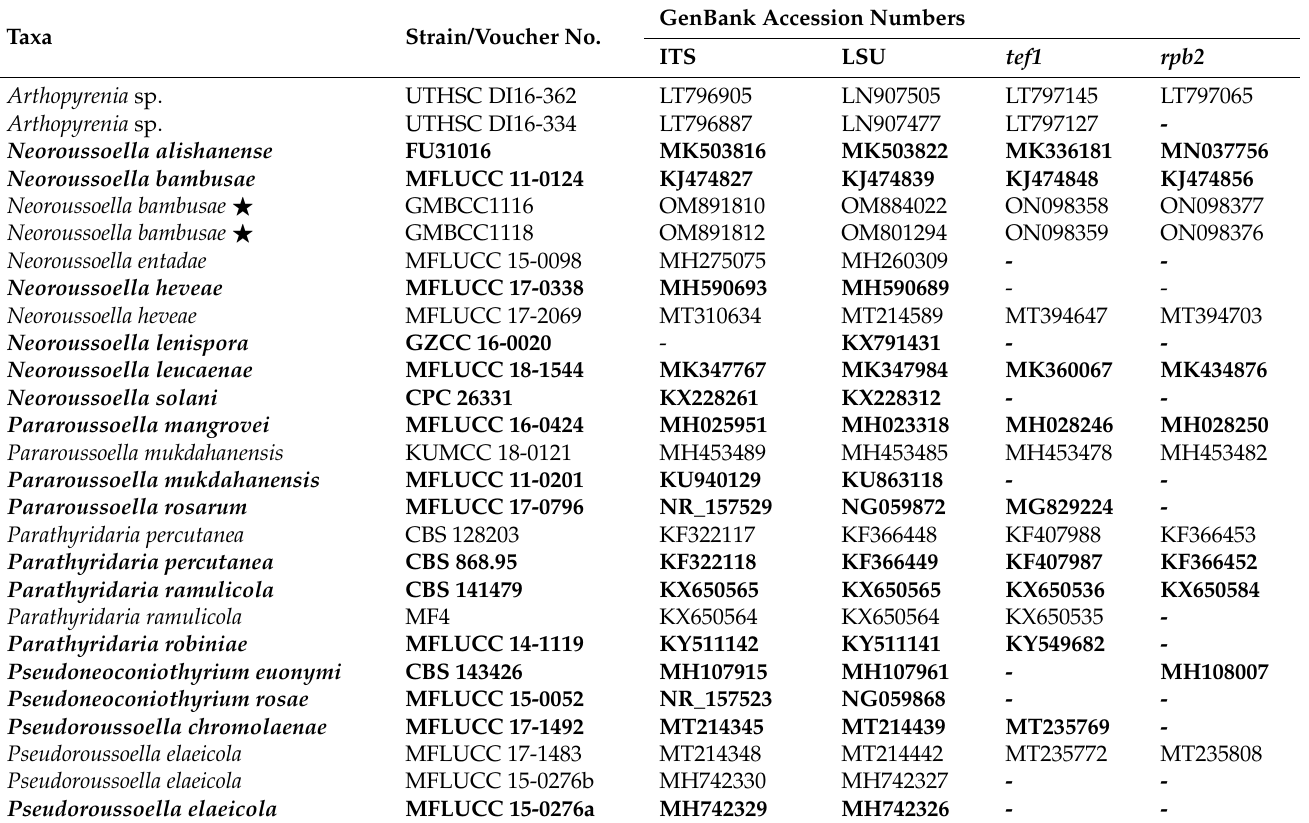
Table 3. Isolates or specimens used in this study and their GenBank accession numbers. The newly generated sequences are marked with asterisk “ (cid:70) ” and ex-type strains are in bold, “ - ” means sequences data are unavailable in the GenBank